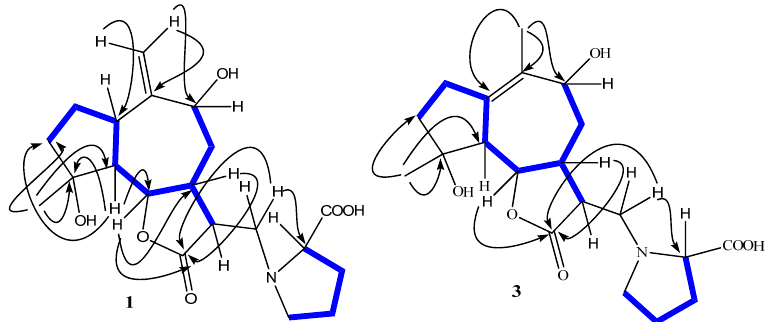
Figure 2. Selected HMBC ( → ) and COSY ( ) NMR correlations of garcinamines F ( 1 ) and H ( 3 ) The key HMBC correlations were those from H 3 -15 to C-3, C-4, and C-5; from H 2 -14 to C-1, C-9, and C-10; from H-6 to C-12; and from H 2 -13 to the proline carbons C-2 ′ and C- 5 ′ . ROESY correlations of H-6 with H 3 -15 and H-11, of H-5 with H-1 and H-7, and of H-7 with H-9 defined the relative configuration of the stereogenic centers. Garcinamine G ( 2 ) showed the same molecular formula C 20 H 28 NO 6 as garcinamine F and also very similar 1 H (Table 2) and 13 C (Table 1) NMR spectra (see Supplementary Ma- terials). Analysis of COSY, HSQC, and HMBC 2D NMR spectra led to the assignment of all the H/C resonances and to the definition of a planar structure identical to that of garcin- amine F, clearly pointing to a diastereomeric relationship between the two compounds. The most significant differences in the 13 C NMR spectra of garcinamines F and G were confined to the signals of C-8, C-9, C-10, and C-14. Similarly, the 1 H NMR spectra of these two compounds mainly differed for the resonances of the seven-membered ring protons. These spectral data strongly suggest that garcinamine G ( 2 ) should be the 9-epimer of garcinamine F. The marked change in the coupling constant pattern of H-9 and the ROESY cross-peaks of H-6 and H-9 with H-8 β support this conclusion. Additionally, garcinamine H ( 3 ) showed the molecular formula C 20 H 28 NO 6 , the same as garcinamines F and G, suggesting a relationship among these compounds. The 13 C NMR and DEPT spectra of 3 (see Supplementary Materials) showed twenty carbon atoms but with a pattern that differed from that of garcinamine F. Indeed, it included two methyl groups, seven methylene carbons (all sp 3 ), six sp 3 methines, and five unprotonated carbon signals (Table 1). The multiplets of the 1 H NMR spectrum (Table 2) were arranged through the COSY spectrum into three spin systems (Figure 2), evidencing the lack of proton con- nection between the H 2 -2/H 2 -3 fragment and the remaining protons of the guaiane skele- ton. Key HMBC correlations from H 3 -15 to C-3, C-4, and C-5 and from H 2 -2 to C-1 defined the structure of the five-membered ring. Correlations from the allylic H 3 -14 to the oxygen- ated C-9 and to the sp 2 C-1 and C-10 defined the structure of the seven-membered ring with a double bond between the two latter carbons. Finally, correlations from H-6 to C-12 and from H 2 -13 to the proline carbons C-2 ′ and C-5 ′ completed the structure of garcina- mine H ( 3 ). ROESY correlations of garcinamine H paralleled those of garcinamine G for common stereocenters and allowed the assignment of the relative configuration to 3 . Thus, garcinamine H is an isomer of garcinamine G showing a somewhat rare Δ 1,10 double bond in place of the Δ 10,14 one. This is the first finding of this structural feature in A. garcinii.